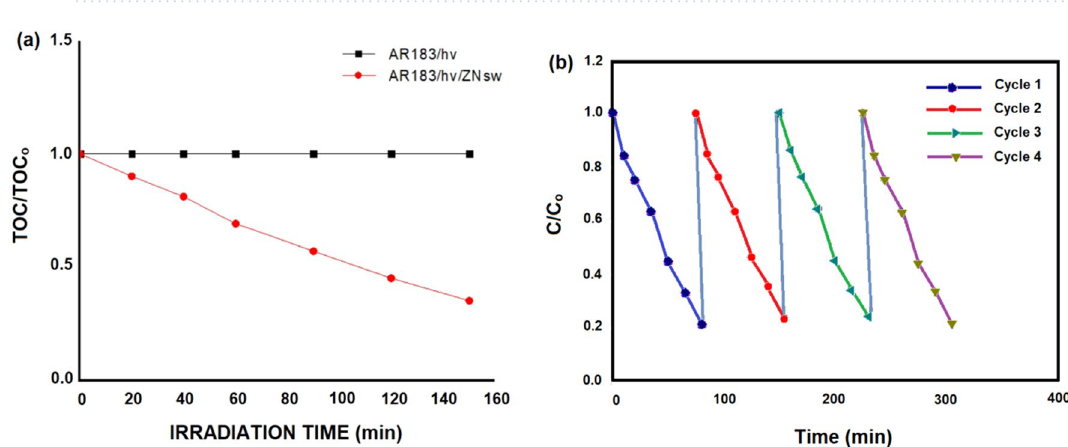
Figure 7. ( a ) Azo Dye AR183 photocatalytic mineralization in the presence of ZNsw and ( b ) Reusability of ZNsw in the photo-degradation of Azo Dye